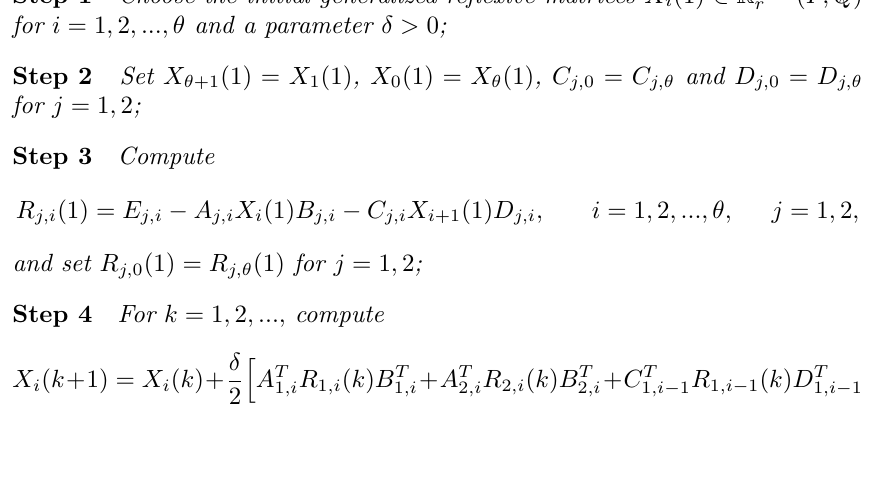
Algorithm 1. ( GI algorithm to solve (1.4) over the generalized reflexive matrices